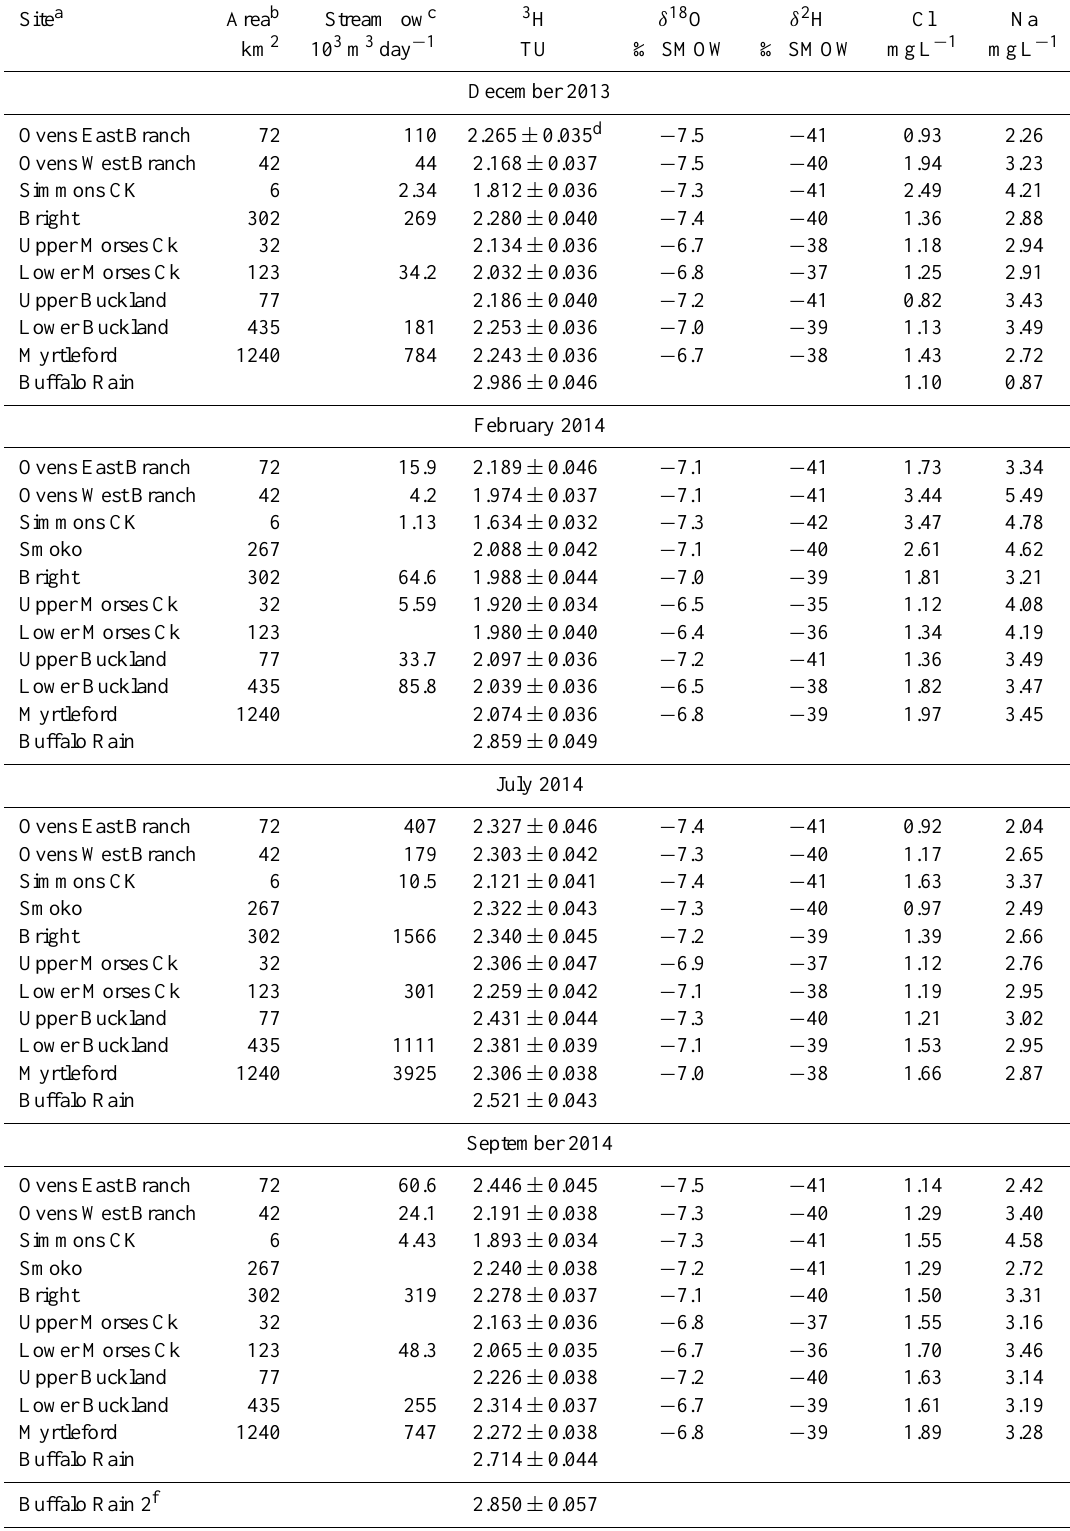
Table 1. Geochemistry of the Ovens River and